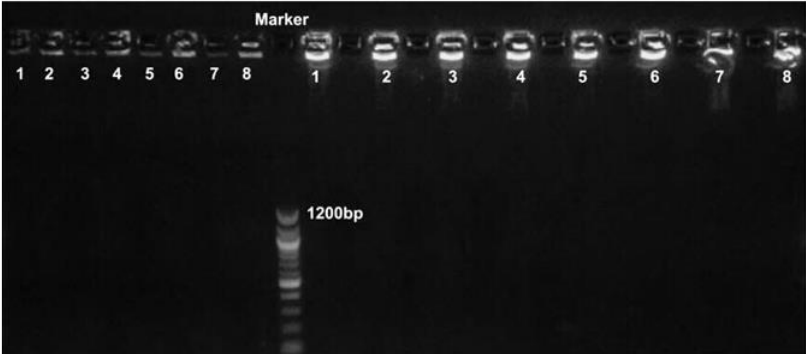
Figure 2. Gel electrophoresis of RCA reaction and HRCA reaction. In the middle of the gel elec- trophoresis map is a DNA Marker; the 8 wells left of the Marker are RCA products, and the 8 wells right of the Marker are HRCA products.